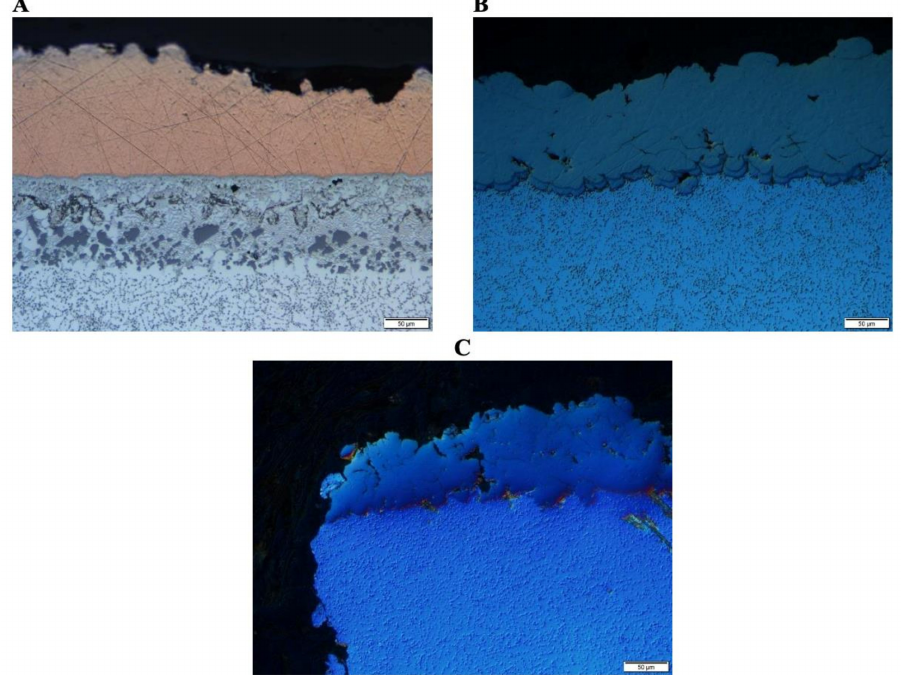
Figure 4. ( A ) Optical micrograph of the copper CGDS processed A365 HPDC system following solution heat-treating. ( C ) Optical micrograph of the titanium CGDS processed A365 HPDC system following solution heat-treating. ( B ) Optical micrograph of the nickel CGDS processed A365 HPDC system following solution heat-treating. Black portions within the micrographs capture the mounting material. The scale bars embedded within each micrograph presented represent 50 µ